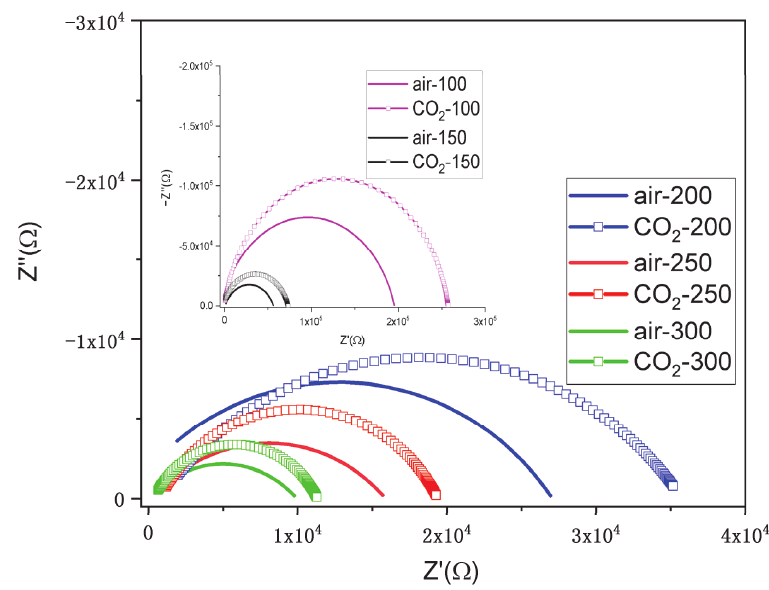
Figure 11. Nyquist representation of the impedance plots of the ITO:Zn/Si film in air and in CO 2 (1000 ppm in air) at different temperatures (100–300 °C).